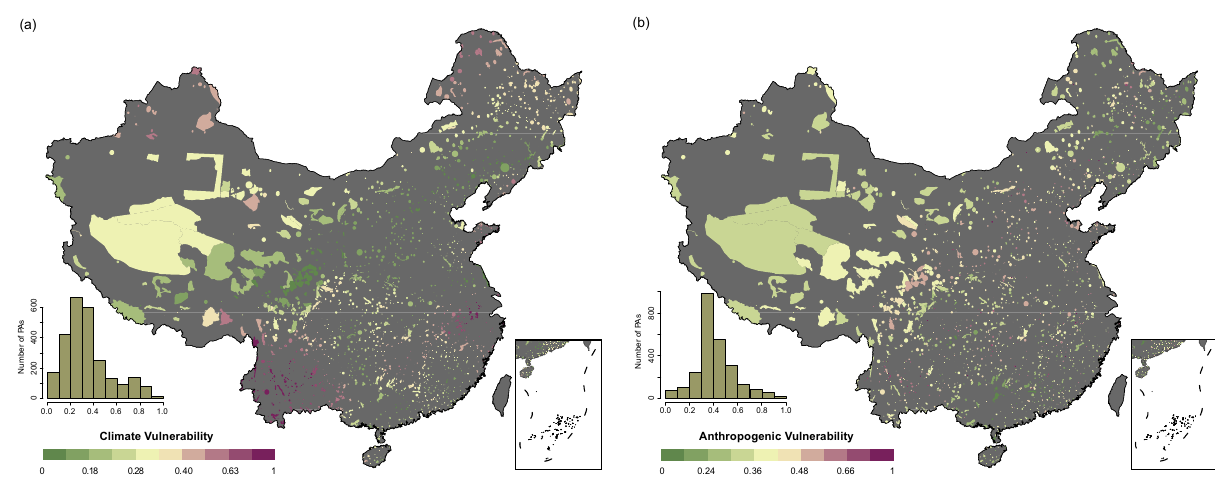
Fig. 1 Spatial patterns of climate and anthropogenic vulnerabilities across protected areas (PAs) in China. a climate vulnerability and b anthropogenic vulnerability. Values close to 1 represented by warmer color indicate high climate or anthropogenic vulnerability. The insets in each sub fi gure show the frequency distribution of respective vulnerability